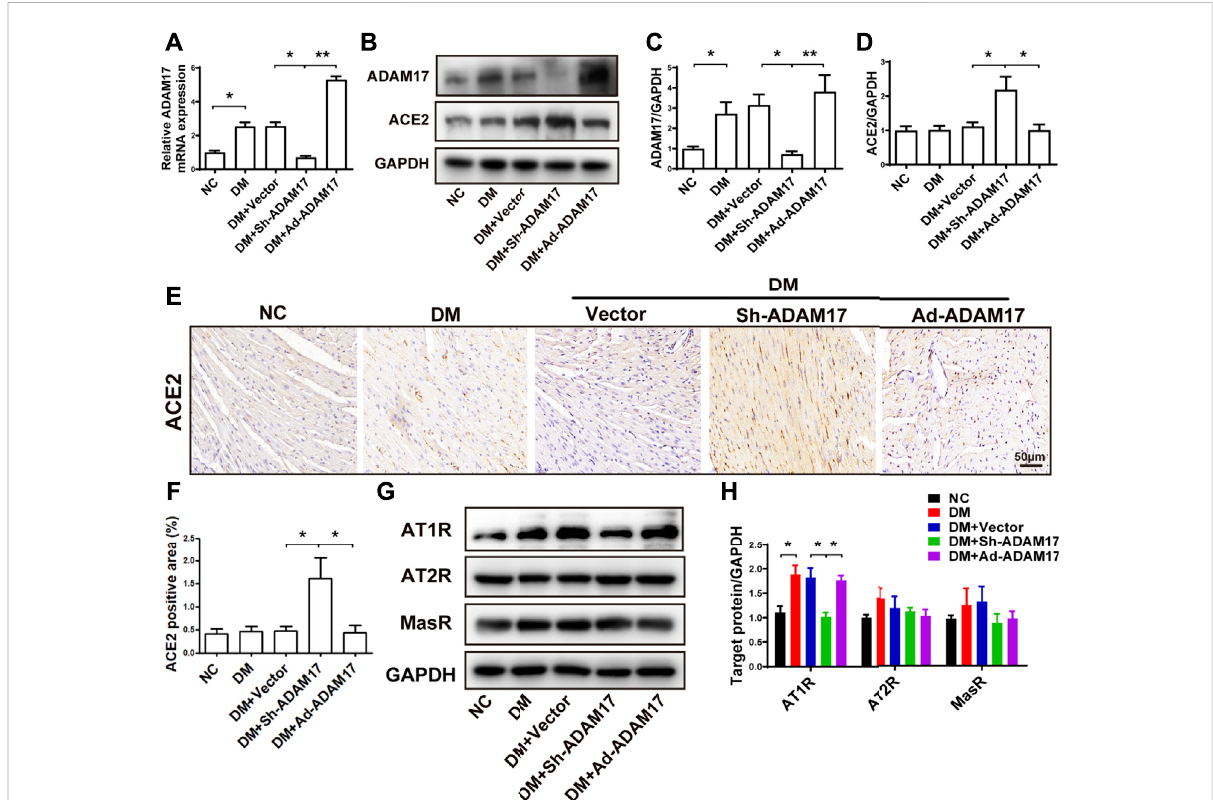
FIGURE 3 ComparisonofADAM17,ACE2,AT1R,AT2RandMasRexpressionin5groupsofmice. (A) Quanti fi cationofmRNAlevelofADAM17in5groupsof mice. (B) Representative Western blot images of ADAM17 and ACE2 in 5 groups of mice . (C) Quanti fi cation of protein expression of ADAM17 in 5 groups of mice. (D) Quanti fi cation of protein expression of ACE2 in 5 groups of mice. (E) Representative immunohistochemical staining of ACE2 (Scale: 50 μ m) in 5 groups of mice. (F) Quantitative analysis of ACE2 expression in 5 groups of mice. (G) Representative Western blot images of AT1R,AT2RandMasRin5groupsofmice. (H) Quanti fi cationofproteinexpressionofAT1R,AT2RandMasRin5groupsofmice.Datawereexpressed as the means ± SEM. * p < 0.05, ** p < 0.01, *** p < 0.001. n = 6 per